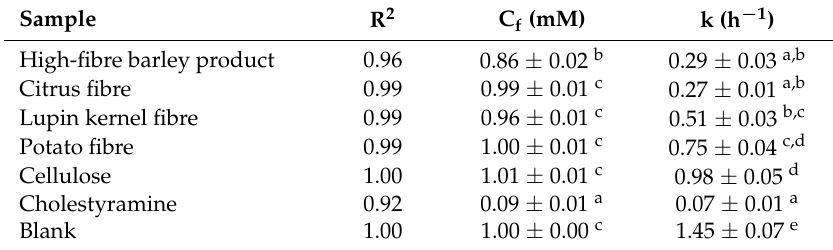
Table 2. Correlation coefficients (R 2 ), concentration of taurocholic acid after reaching equilibrium (C f ), and apparent permeability rate constant (k) determined by first-order kinetic fitting of bile acid release from simulated chymes ( n =